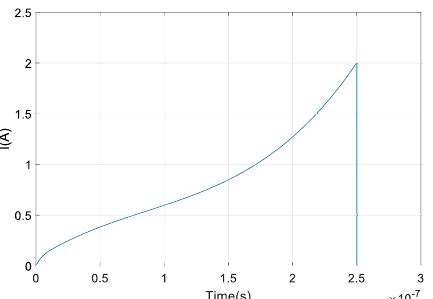
Figure 4. Current pulse waveform for generating a chirped signal with current pulse duration of T s = 250